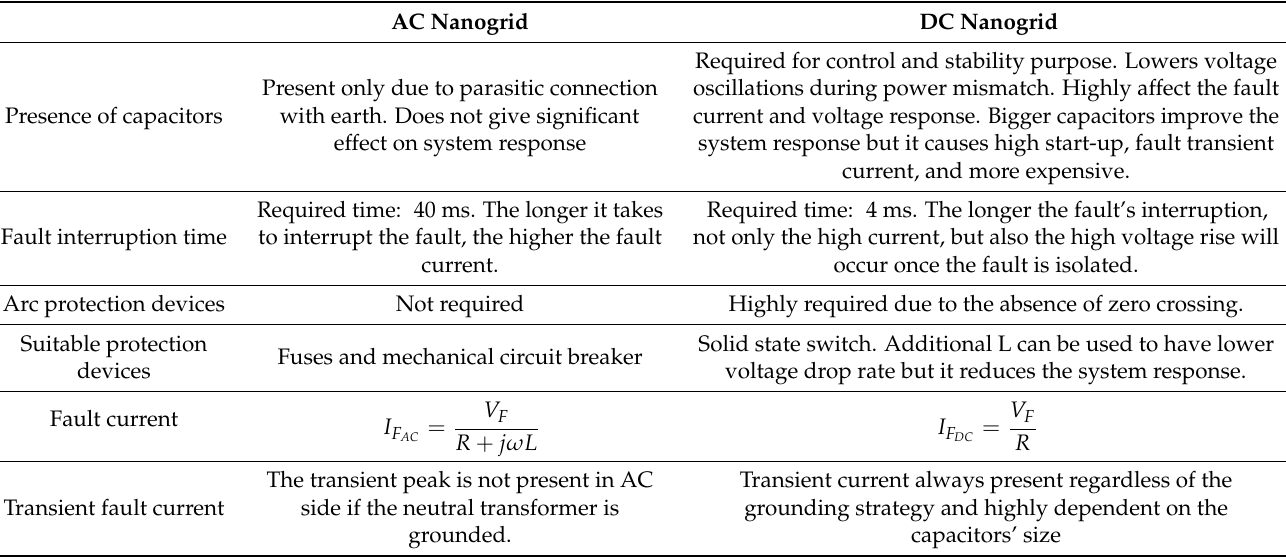
Table 4. Protection mechanisms